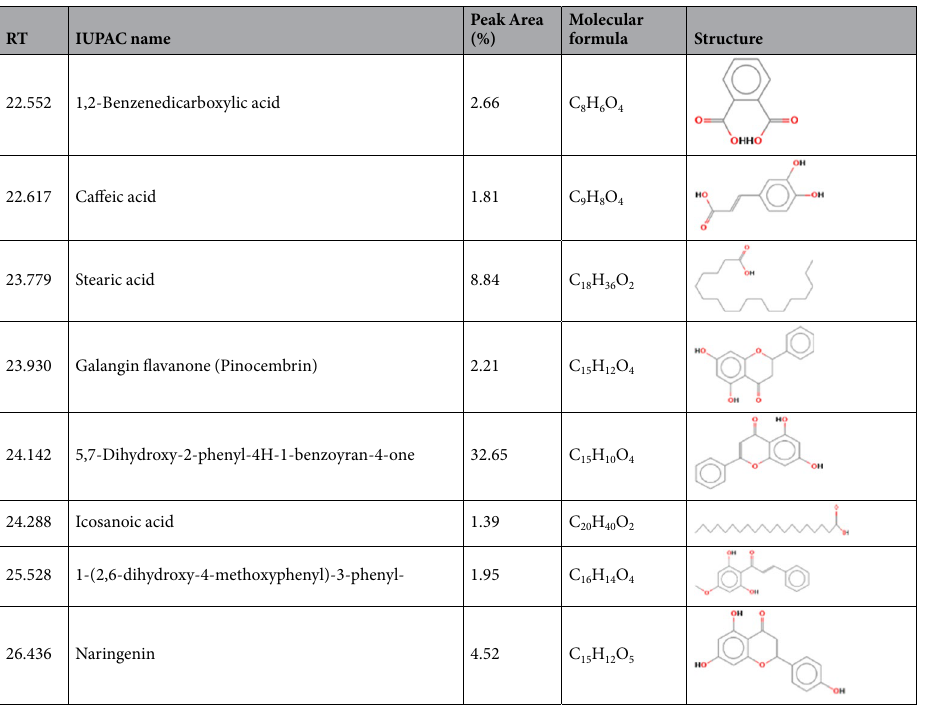
Table 1. GC-MS analyzes of the utilized